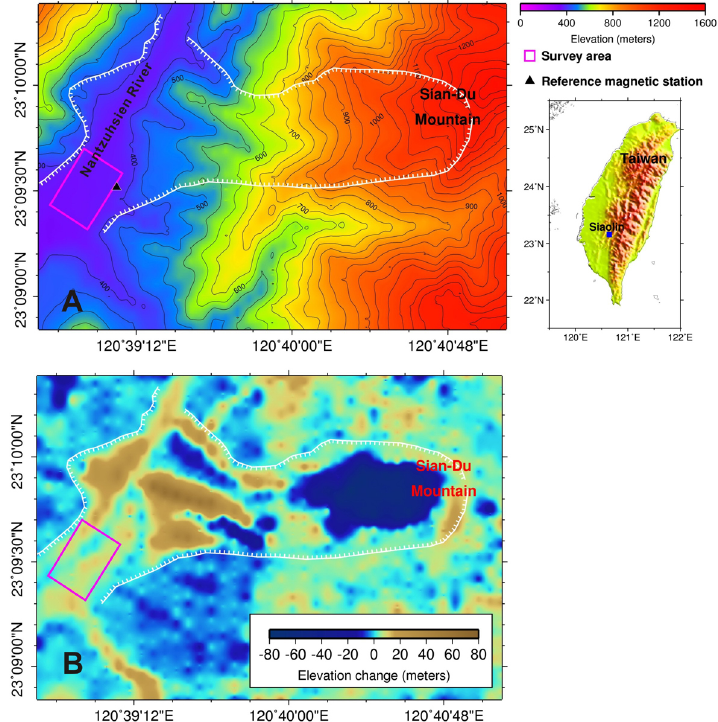
Fig. 1. (a) The topography and (b) its changes due to the landslide event in the Siaolin area. Purple rectangles in each plot indicate the areas of the magnetic survey.